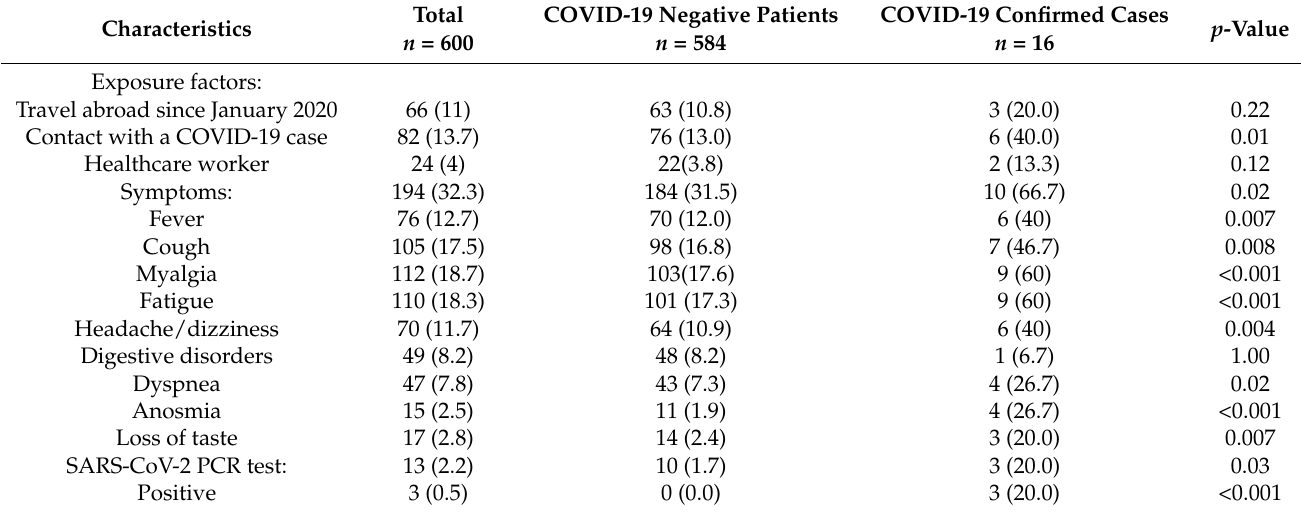
Table 2. SARS-CoV-2 exposure factors and symptoms depending on the COVID-19 status.